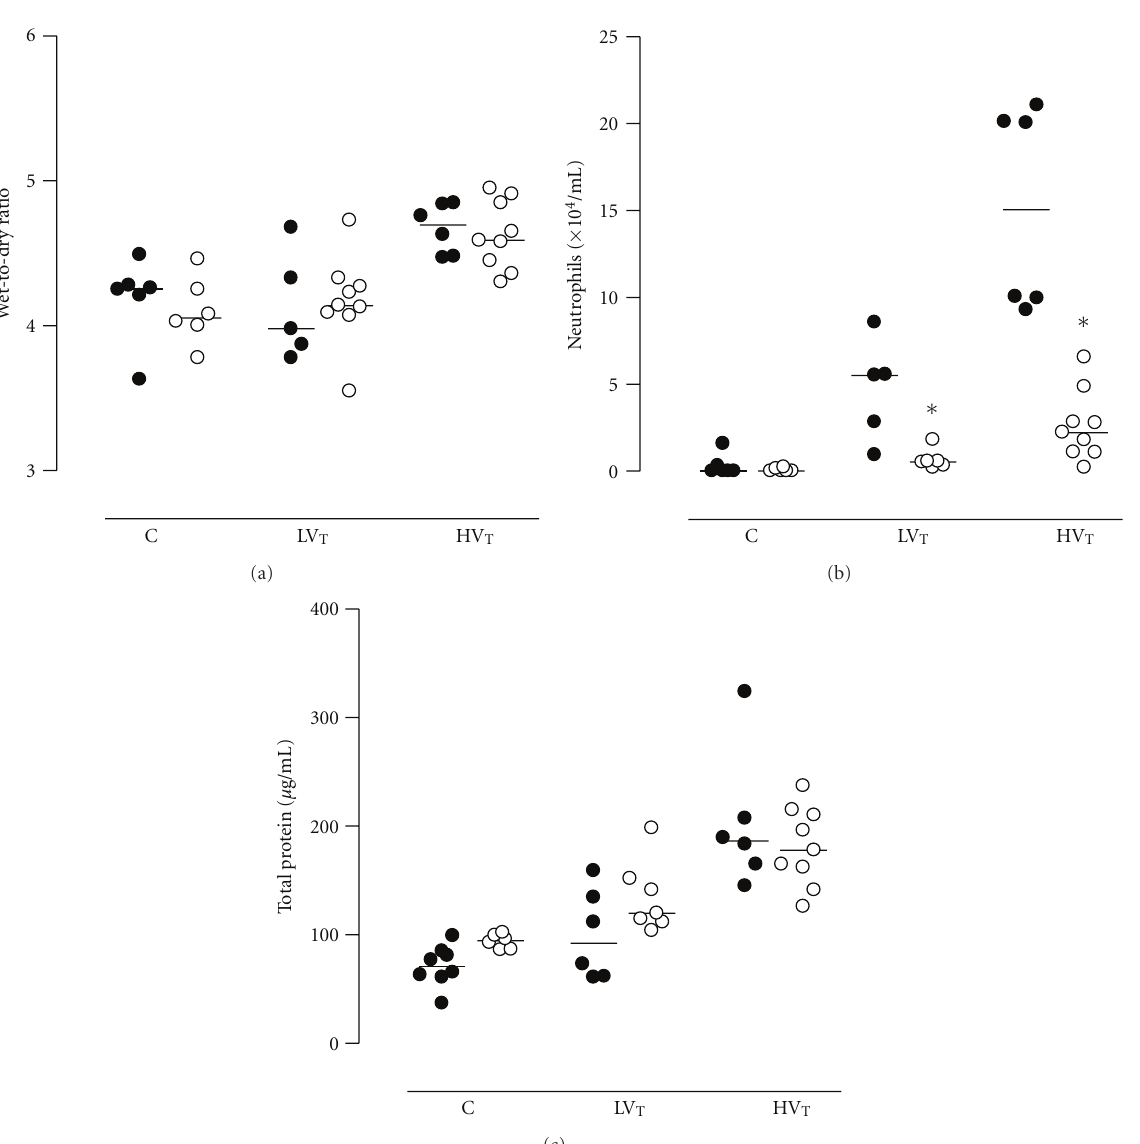
pulmonary levels of inflammatory mediators, even in the control, nonventilated mice. Plasma levels of IL-6 were lower in PAI-1 − / − mice as compared to Wt mice. Notably, PAI-1 deficiency did not result in changes of other endpoints of lung injury, that is, gas exchange, W/D, BALF protein levels, and